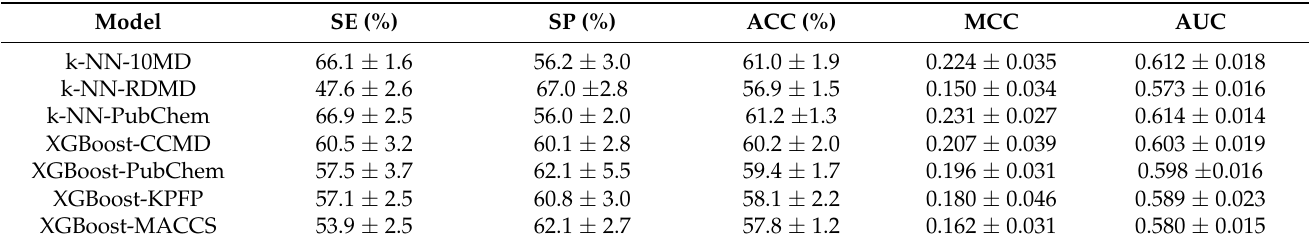
Table 3. The five-fold cross-validation results of the optimal classification models based on only molecular fingerprints or